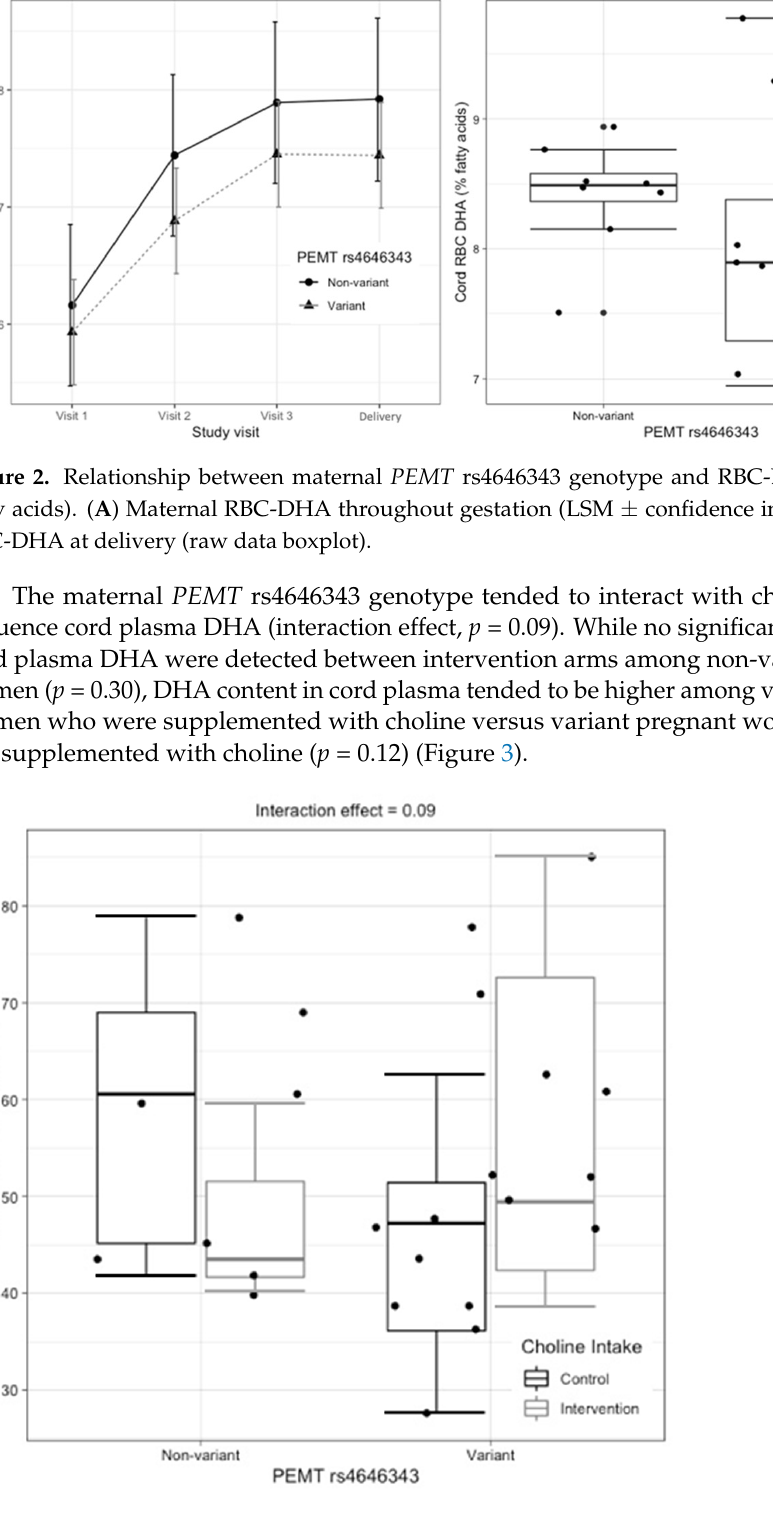
Figure 3. Interactive effects of maternal PEMT rs4646343 genotype and maternal choline intake on cord plasma DHA ( µ g/mL) (raw data boxplot).